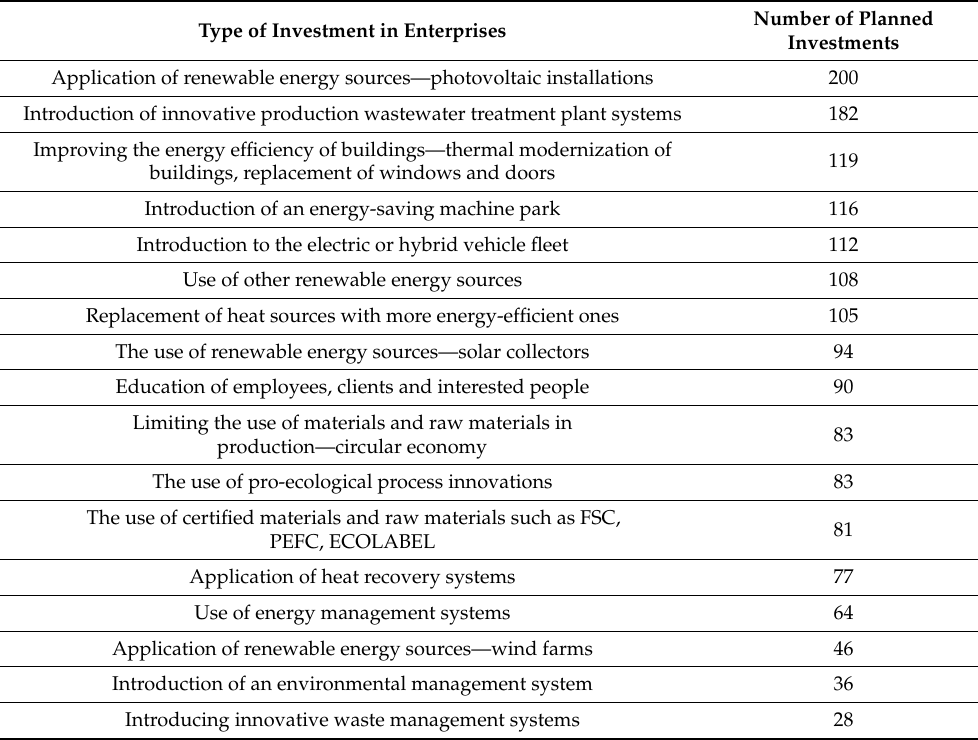
Table 2. Expectations of entrepreneurs with regard to financing pro-ecological investments. Type of Investment in Enterprises